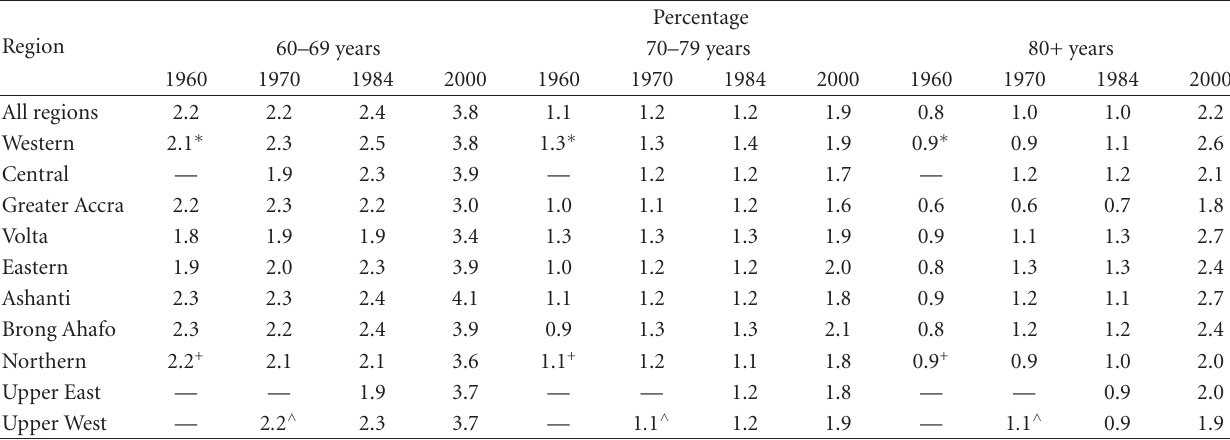
Table 3: Proportion of Ghana’s elderly to total population by region,